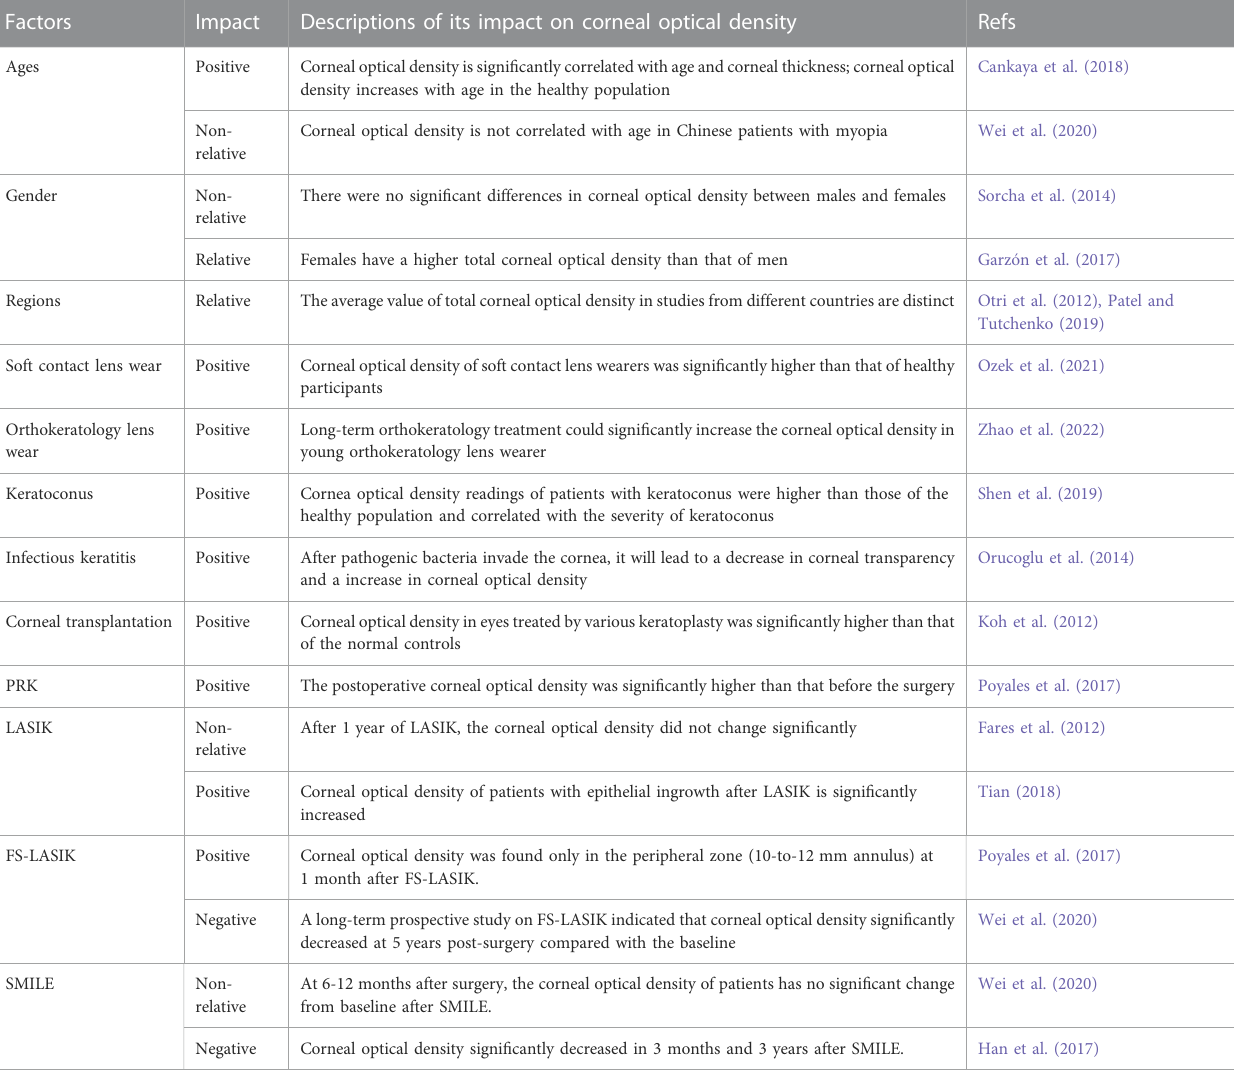
TABLE 2 In fl uencing factors of corneal optical density in healthy people and patients with corneal diseases.